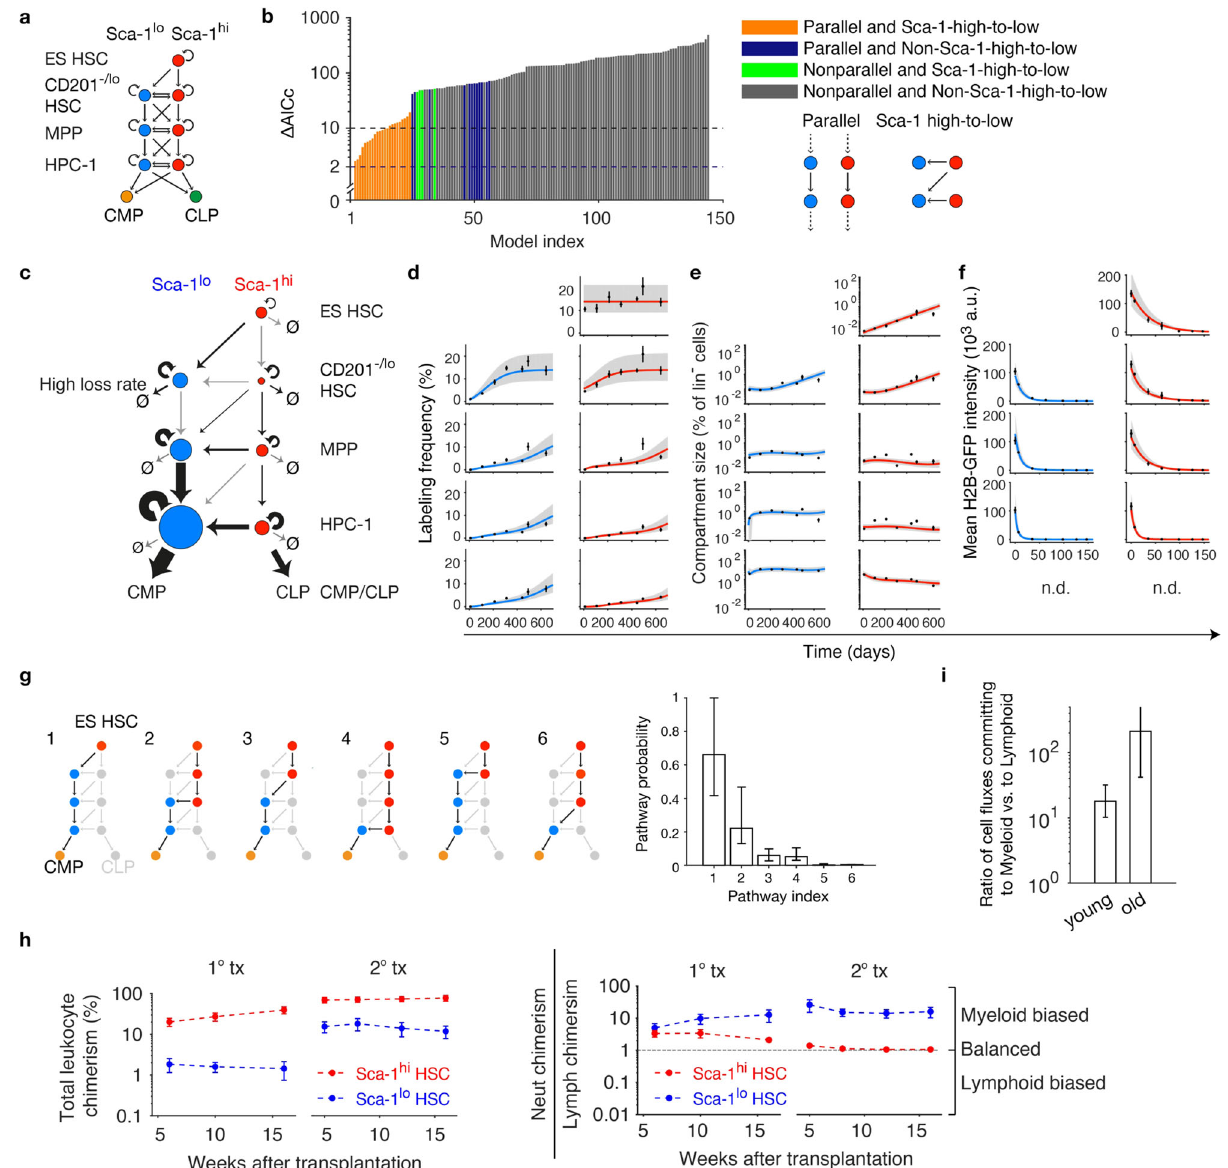
Fig. 2 Statistical inference of HSC differentiation pathways. a Model scheme, with subdivision of HSCs and progenitors according to Sca-1 expression and, for HSCs, CD201 expression. Straight arrows denote cell differentiation (vertical), or change in Sca-1 expression (horizontal), or both (diagonal); curved arrows denote cell proliferation. All possible differentiation are superimposed. b Model selection by bias-corrected Akaike information criterion (AICc) against experimental data for HSC fate mapping, mitotic history, and relative cell numbers. Models are classi fi ed (and color-coded accordingly) by two features: parallel differentiation pathways and irreversible loss of Sca-1. The best- fi tting model c has Δ AICc = 0. None of the remaining 143 models is within Δ AICc < 2. Further models with acceptable evidence ( Δ AICc < 10) are all variants of the best- fi tting model (see Supplementary Fig. 5b). c Best model selected by experimental data. Arrow width signi fi es values of the corresponding differentiation or proliferation rates, while node size quanti fi es cell number (relative to lin − cells) in each compartment at 100 days of chase; see Supplementary Table 1. Fits of the best model for RFP labeling frequency propagation ( d ), compartment size ( e ), and H2B-GFP dilution ( f ) (experimental data: mean ± SEM; mice in d and e are the same as in Fig. 1c – e; for f , n = 3, 4, 4, 2, 2, 4, 4 mice/consecutive timepoint (0 − 21 weeks of chase) were analyzed; model fi t: straight line, best fi t; gray-shaded areas, 95% con fi dence bounds). g Inferred lineage pathways to CMPs and their relative contributions to generation of CMPs (showing the probability that a CMP was generated by each pathway; error bars, 95% prediction bands). h As predicted by the model, transplanted Sca-1 hi HSCs, but not Sca-1 lo HSCs, yielded lymphoid progeny. 100 Sca-1 hi or Sca-1 lo donor HSCs were competitively transplanted and contribution to peripheral blood neutrophils, B and T cells was determined (data re-analyzed from Morcos et al. 25 ). Lineage bias of donor-derived leukocytes was calculated (Neutrophil chimerism/[B + T cell chimerism]/2; n = 4 recipient mice for Sca-1 hi HSCs and n = 3 for Sca-1 lo HSCs in primary and secondary transplantation; mean and SEM are shown). i Ratio of cell fl uxes between Sca-1 lo HPC-1 → CMP and Sca-1 hi HPC-1 → CLP for young and old mice (error bars, 95% prediction